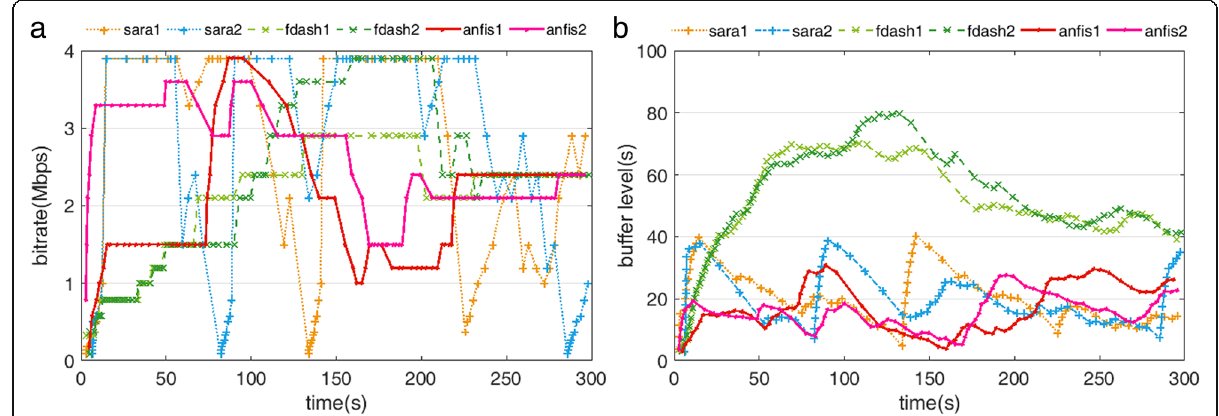
Fig. 7 Simulation results in second Wi-Fi environment. a The segment bit rate requested by client over time. b The client ’ s playback buffer